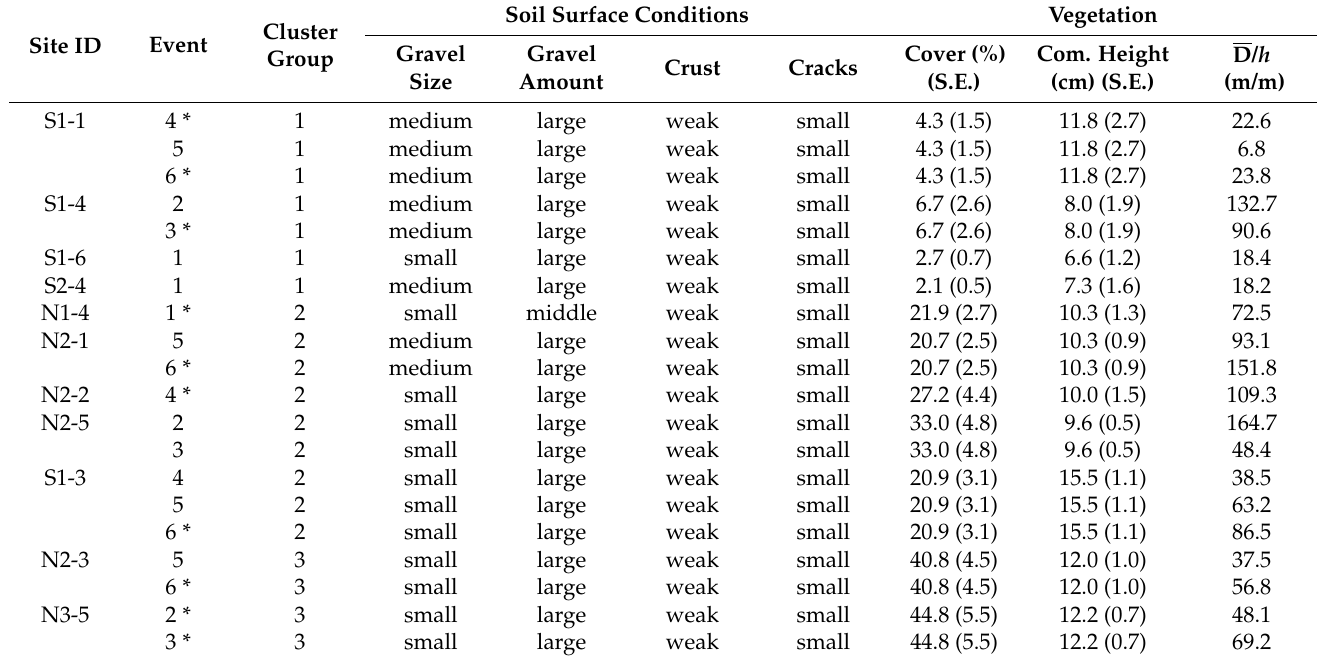
Table 1. Conditions of the soil surface and vegetation at each site. The initial letter of the Site ID (S or N) indicates that the site is located on the south or north pediment. The soil surface conditions are described qualitatively in relation to gravel and crust conditions in the whole study area. Under “Gravel size”, “medium” means 1–2 cm and “small” means 0.5 to 1 cm in size. Under “Gravel amount”, “large” means that about 70% of the surface is covered by gravel, and “middle” means that about 40% of the surface is covered by gravel. We also recorded the presence of crusts and cracks: a “weak” crust means a slightly aggregated surface, and “small” cracks means the crust is slightly dry and starting to crack. For cover and community height, the mean and standard error (S.E.) in the survey quadrats are shown ( n =